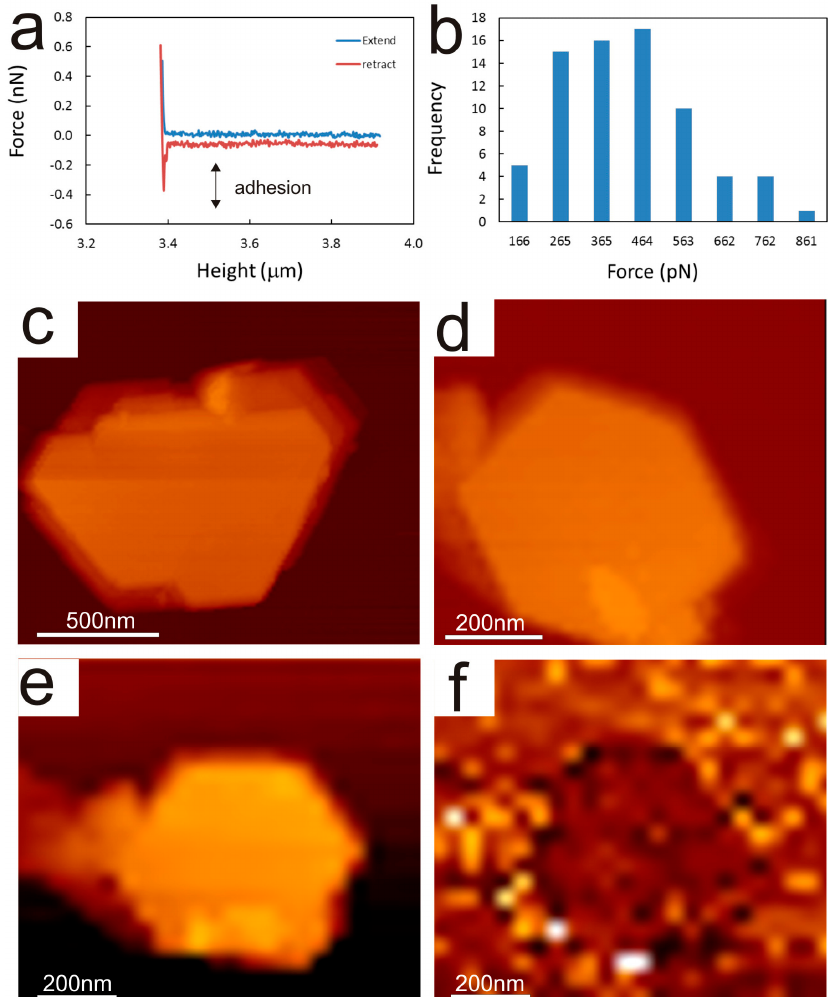
Figure 2. Representative force-distance curve measured over a kaolinite crystal ( a ). Extend and retract curves (blue and red, respectively) are shown. Adhesion region highlighted in plot. ( b ) Representative histogram showing the spread of adhesion measurements over a kaolinite crystal; ( c ) height image (64 × 64 pixels) of a representative kaolinite crystal; ( d ) height image (64 × 64 pixels) of the kaolinite crystal measured in experiment kao-Si-4; ( e ) low resolution (25 × 25 pixels) height image of the crystal shown in ( d ); ( f ) adhesion map of the crystal shown in ( e ).